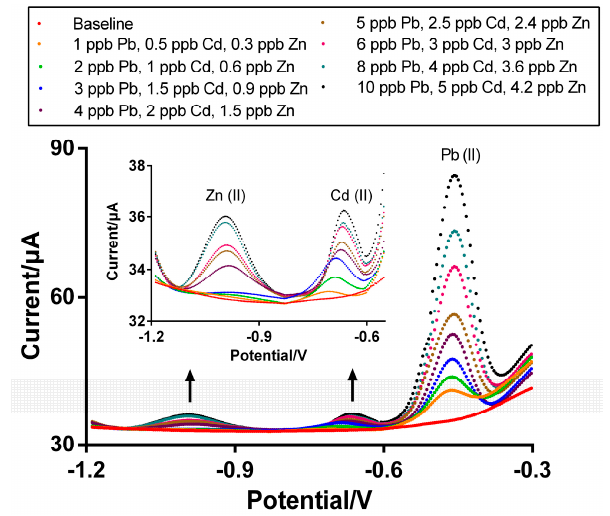
Figure 6. SWASV of multiple heavy metal detection ( a ) Zn 2+ , ( b ) Cd 2+ , and ( c ) Pb 2+ in 0.1 M AcB at pH 4.5. Heavy metal deposition time is 300 s with a − 1.2 V deposition potential, 0.004 V potential step, 0.05 V amplitude, and 20 Hz frequency.